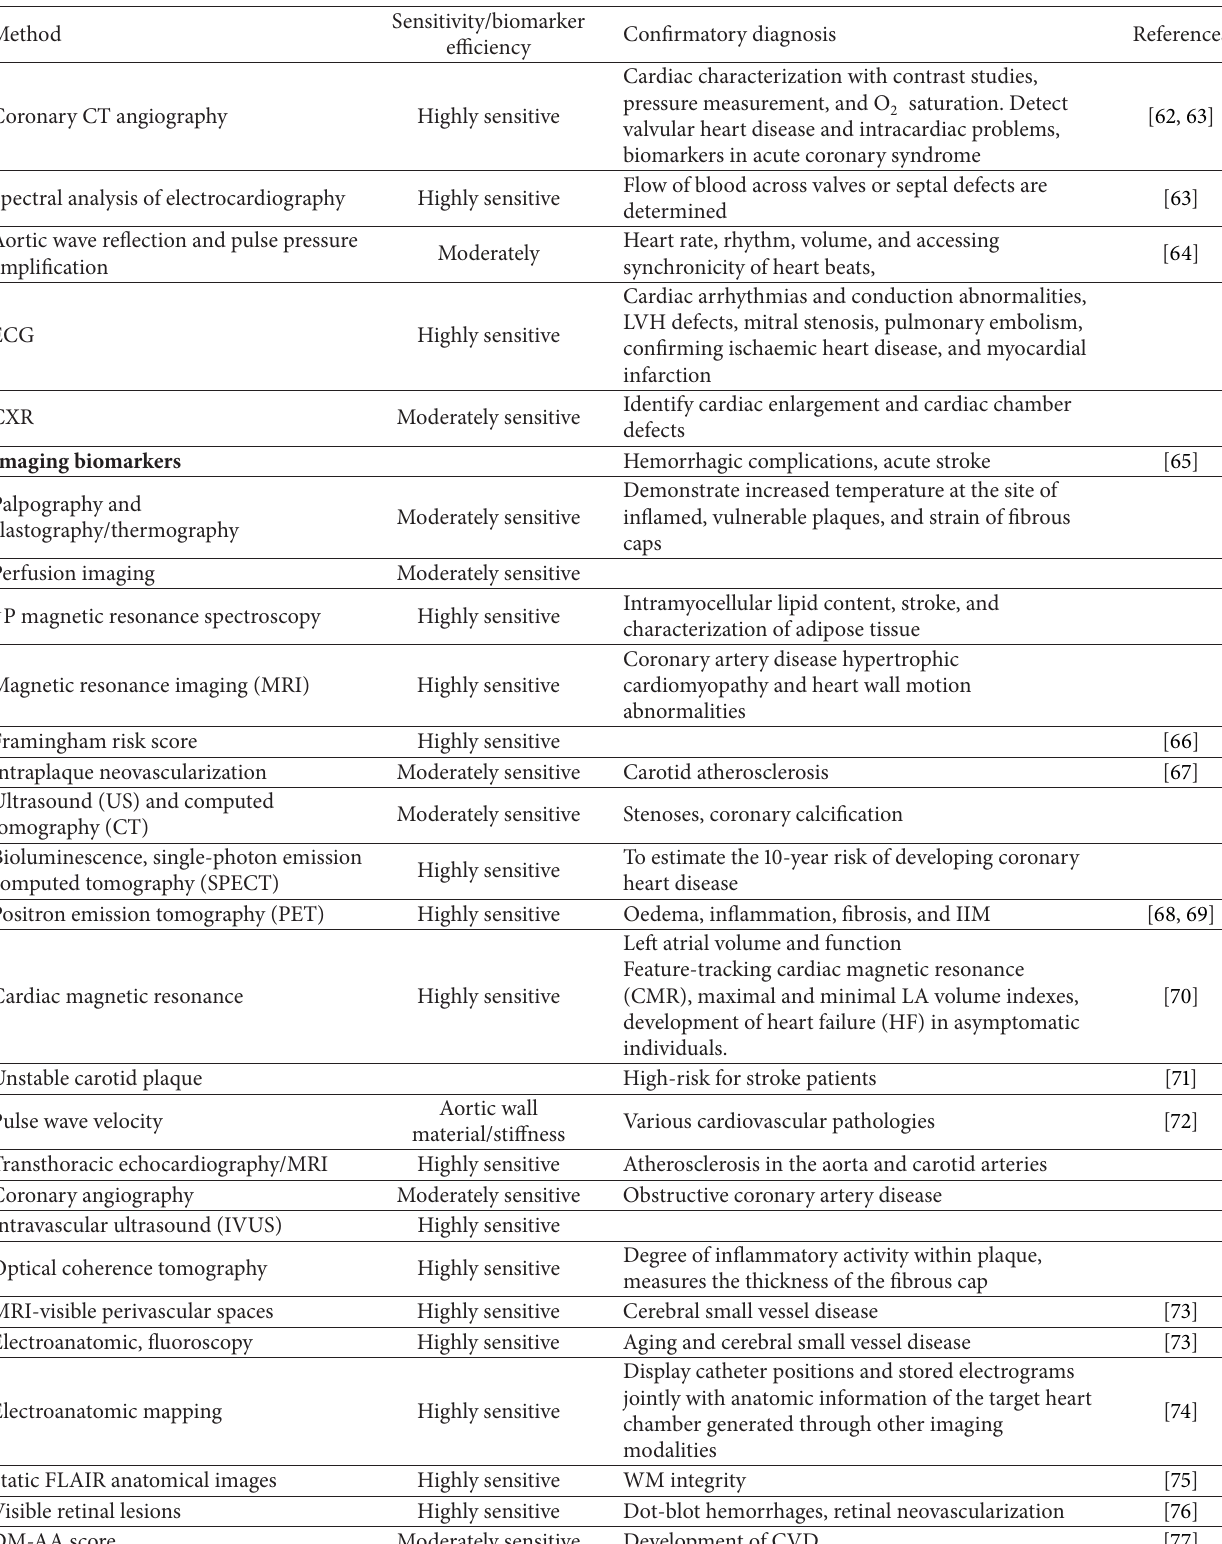
Table 2: Different risk indicating methods and biomarkers used for clinical diagnosis of cardiovascular disease and